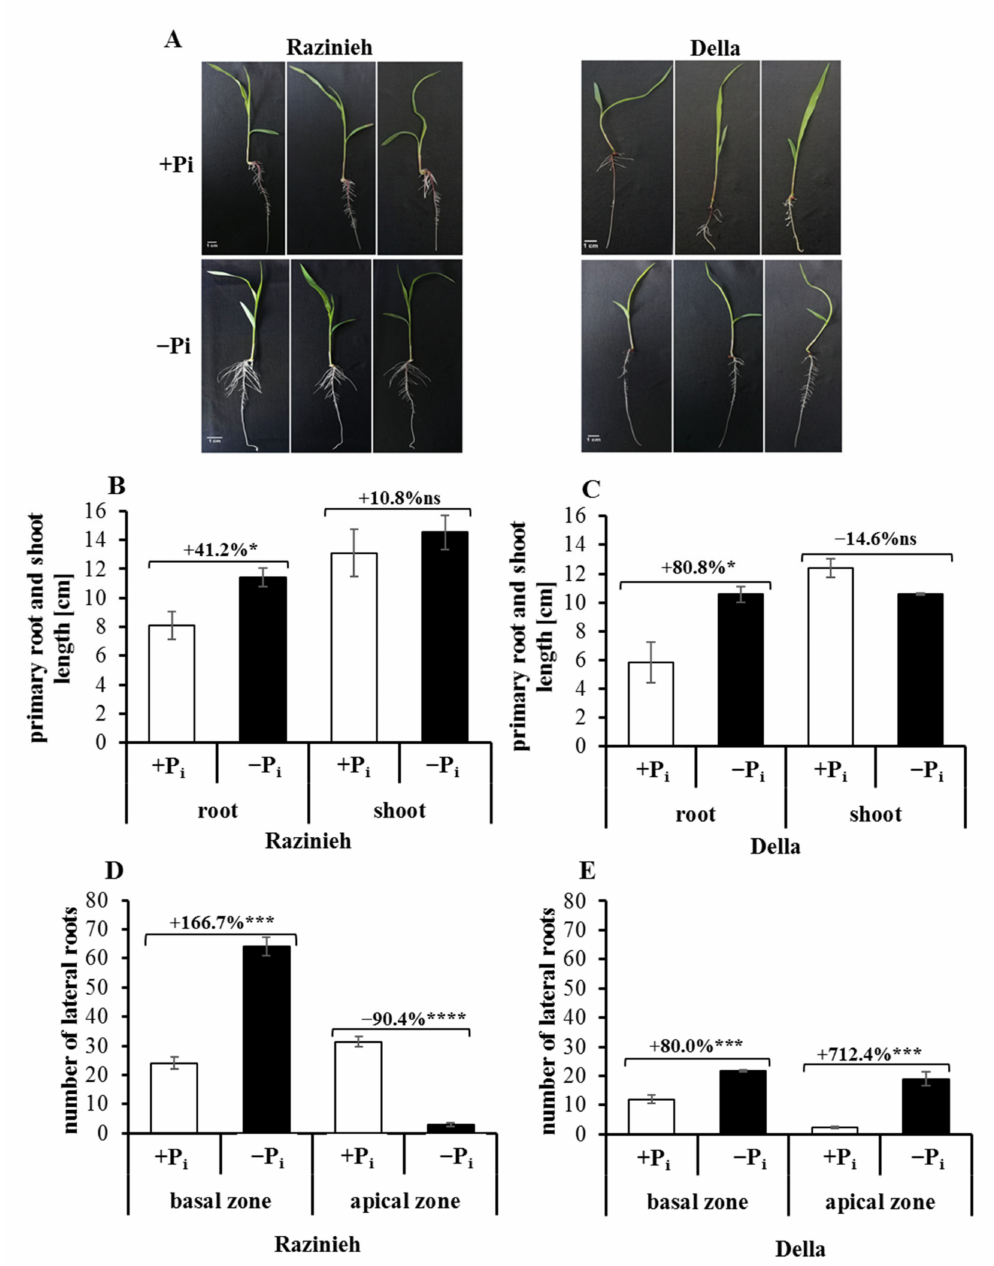
Figure 2. Effect of phosphorus starvation on root system architecture and growth of a grain (Razinieh) and a sweet (Della) sorghum variety. The seeds of two varieties were initially grown in agar with 8% MS for 4 days; after that, the seedlings were transferred to big plates with a wedge containing Hoagland solution and 1.5% phytoagar (pH 5.8) for 6 days. The P i treatments were 2 mM NH 4 H 2 PO 4 (normal condition; +Pi) or zero (phosphorous starvation; − P i ). Plant sampling was conducted after 6 days of P i treatments. Data are presented for ( A ) root system architecture, ( B ) primary root and shoot lengths of Razinieh (cm), ( C ) primary root and shoot lengths of Della (cm), ( D ) number of lateral roots in basal and apical zones of Razinieh, ( E ) number of lateral roots in basal and apical zones of Della. Values are means ± SE; ns: not significant; *, ***, **** are significant at 0.05, 0.001, and 0.0001, respectively, paired two-tailed Student’s t-test; n =